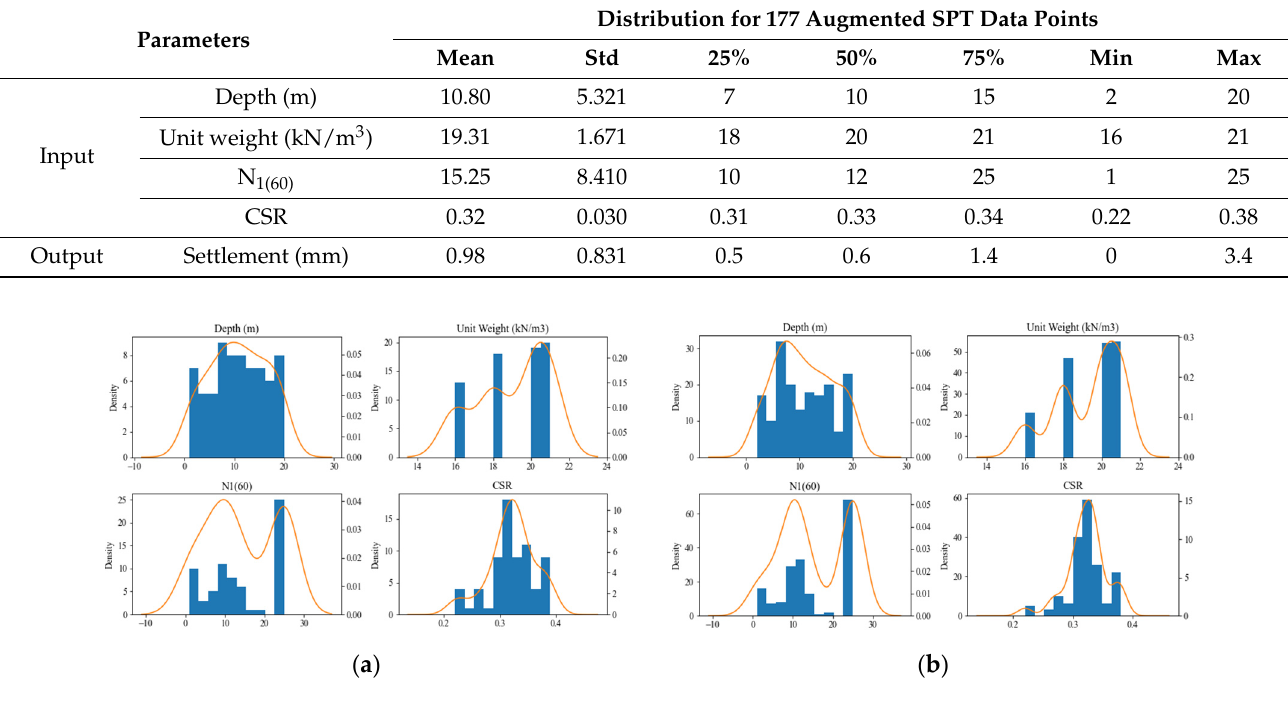
Figure 4. Feature distributions of actual and augmented data. ( a ) Actual data; ( b ) augmented data.